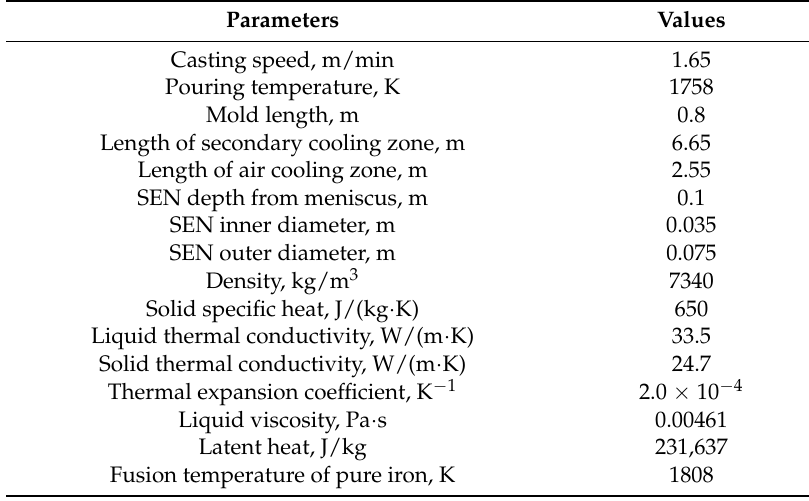
Table 3. Operation parameters and thermophysical